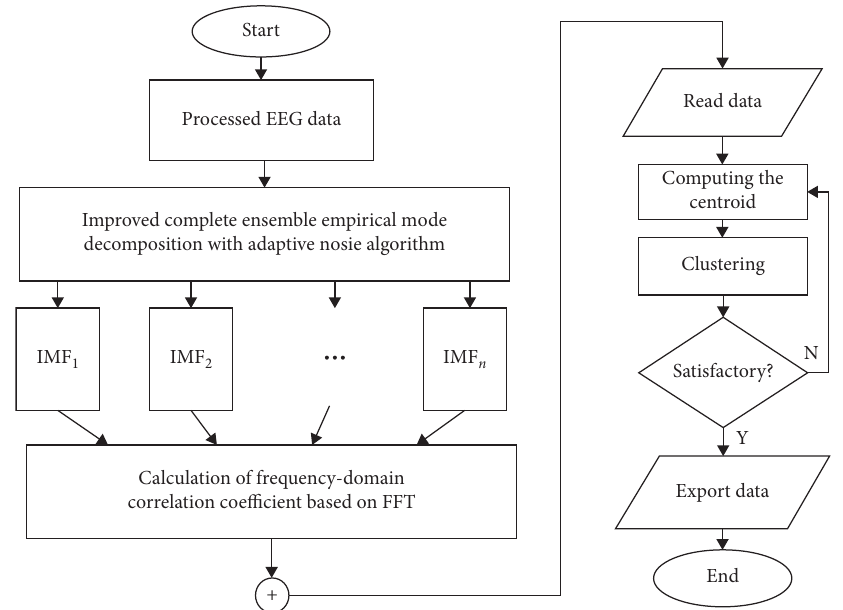
Figure 4: Flowchart based on improved CEEMDAN and